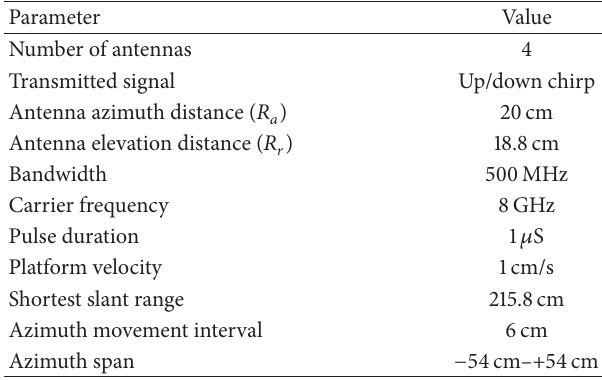
Table 2: Ground-based MIMO SAR system